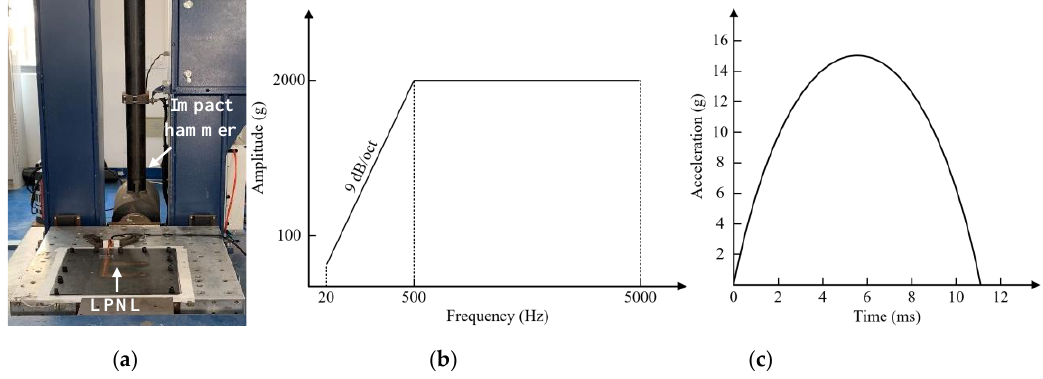
Figure 14. Experimental setup of impact test. ( a ) Experimental setup. ( b ) The impact response spectrum. ( c ) The half sinusoid spectrum.